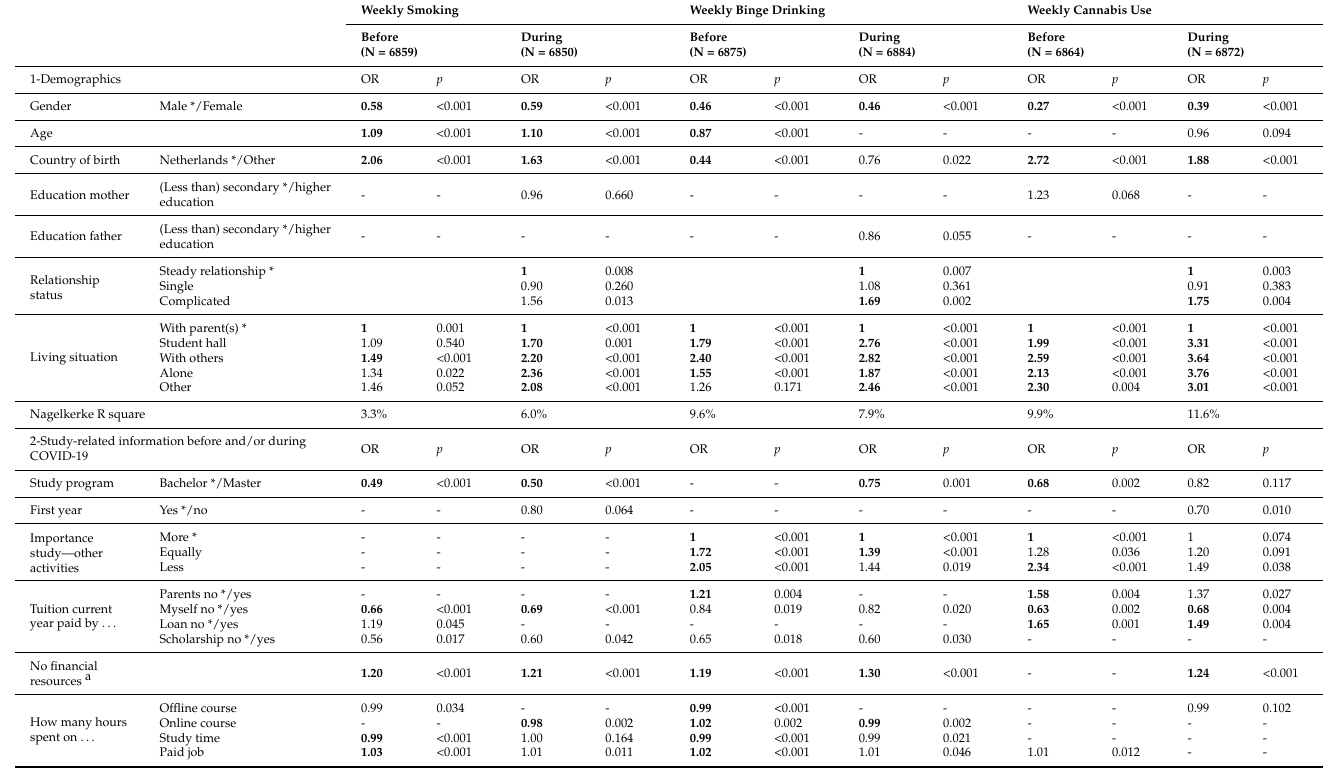
Table 3. Student-, study- and COVID-19-related factors associated with weekly smoking, weekly binge drinking or weekly cannabis use before and during the first COVID-19 lockdown (Model A) # . WeeklySmoking WeeklyBingeDrinking